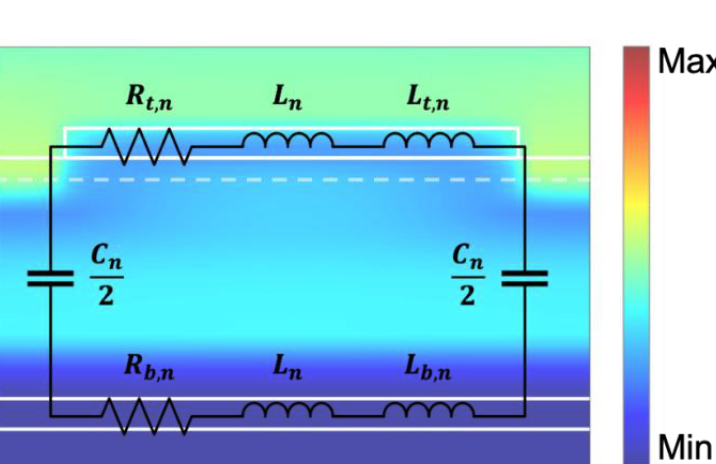
Figure 6. Description of the LSPR mode at the metasurface S3. Equivalent circuit model of the resonant mode at a magnetic field distribution with a normal incidence angle resonance wavelength of 9.2 µm. The color bar indicates the relative magnetic field intensity (H/H 0 ).